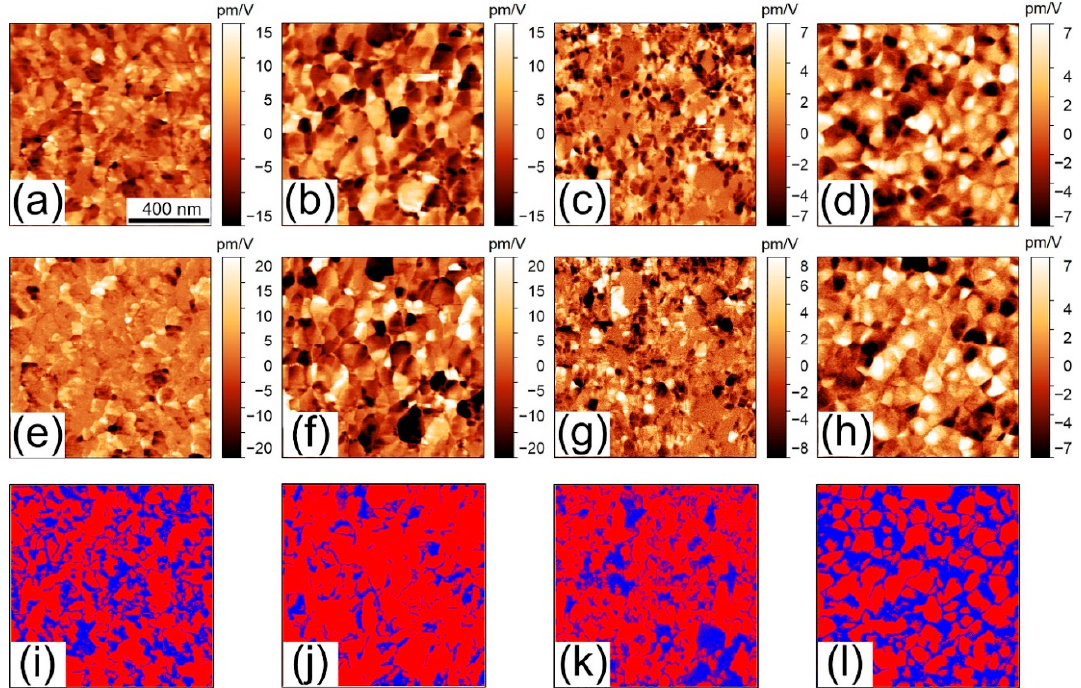
Figure B1. PFM images and phase distribution images in: ( a ), ( e ), ( i ) one-layer; ( b ), ( f ), ( j ) two-layer; ( c ), ( g ), ( k ) three-layer; ( d ), ( h ), ( l ) seven-layer HTD BFO films. ( a )–( d ) Vertical PFM images; ( e )–( h ) lateral PFM images; ( i )–( l ) distribution of the piezoelectrically active (red) and non-active (blue) phases.